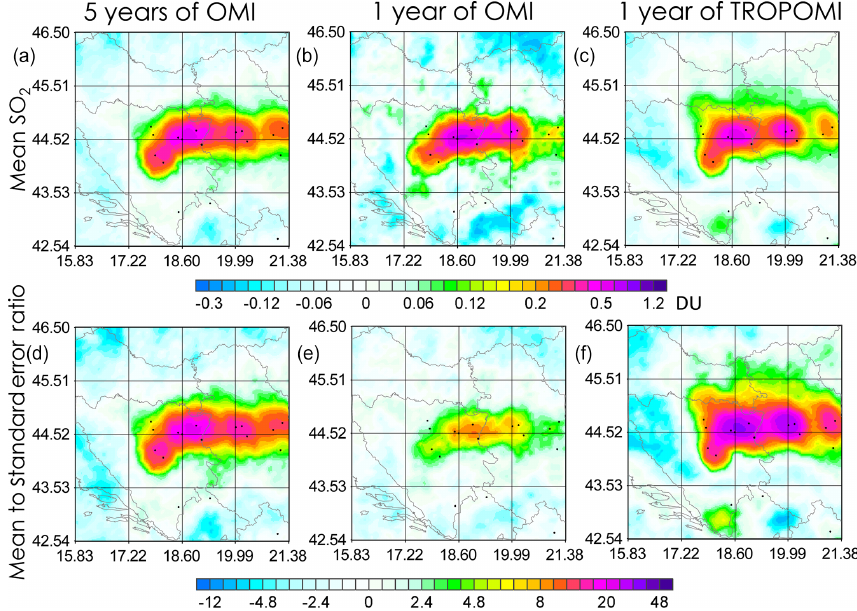
Figure 6. SO 2 hotspot over Serbia and Bosnia and Herzegovina: mean OMI values over a 5-year period (2014–2018) and mean OMI and TROPOMI values over a 1-year period (from April 2018 to March 2019). Data are smoothed by oversampling/pixel averaging with R = 30km. The constant bias is removed. The black dots indicate the emission sources. Panels (a–c) show mean SO 2 and panels (e–f) show the ratios of the mean SO 2 value to the standard error of the mean.